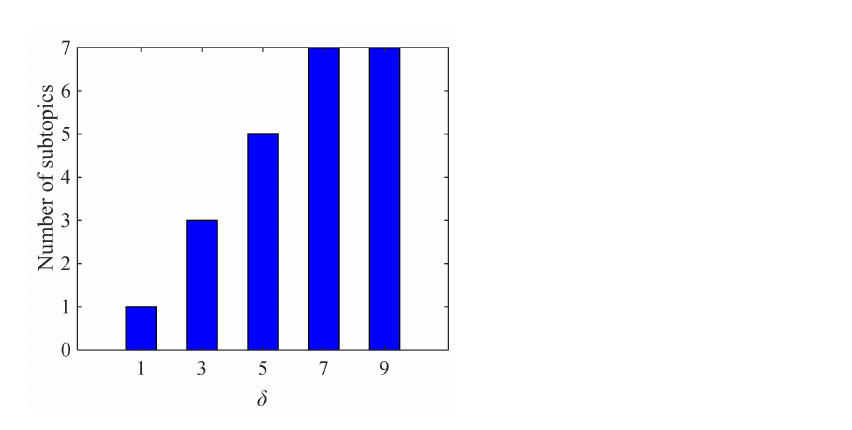
Figure 12. Changes of degree of variation under different information alienation settings.